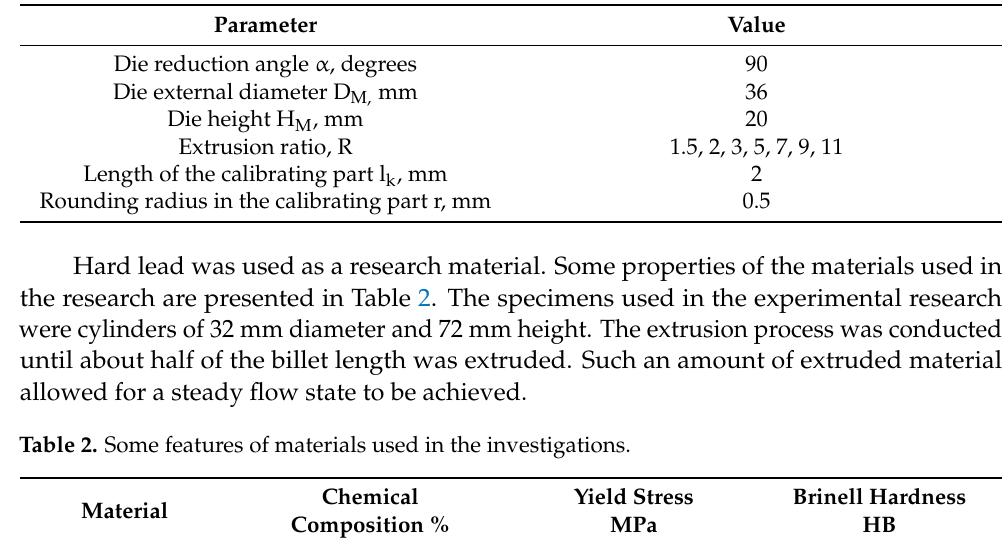
Table 1. Basing dimensions of dies used in the extrusion process.